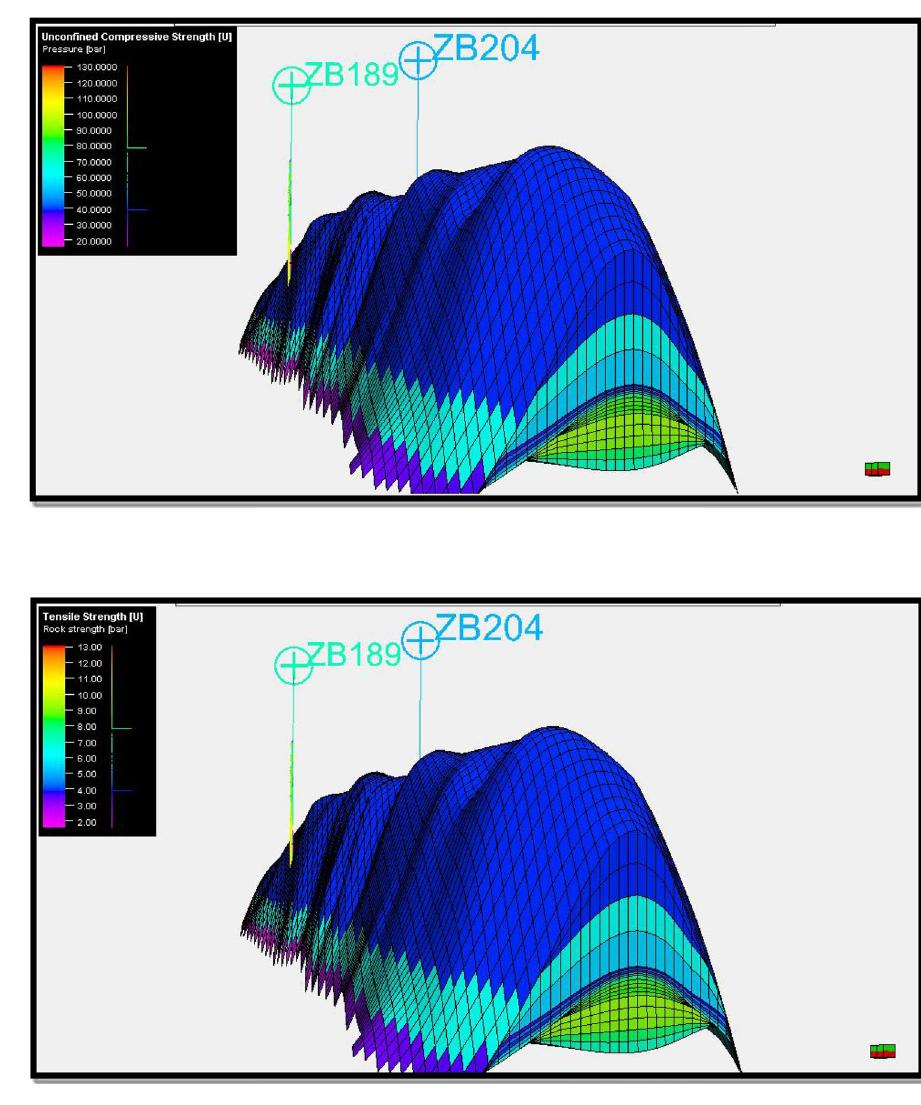
Fig. 20 Overburden